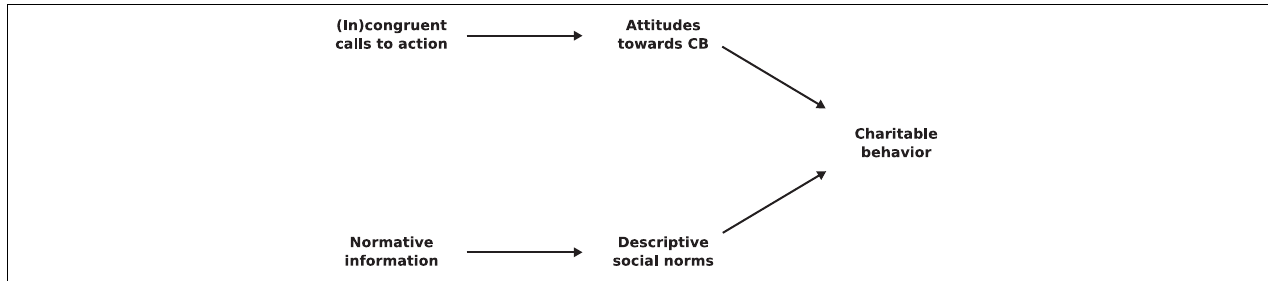
FIGURE 1 | Schematic representation of the proposed effects between (in)congruent calls-to-action, normative information, attitudes toward CB, descriptive social norms and CB.